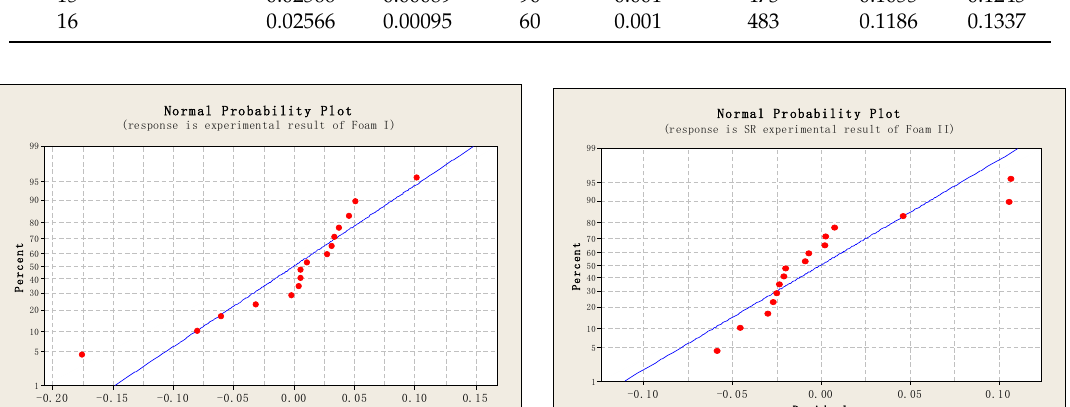
Normal Probability Plot (response is SR experimental result of Foam II)